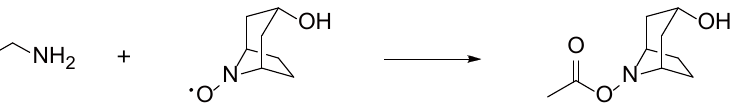
Figure 4. Reaction of NNO and ethylamine.